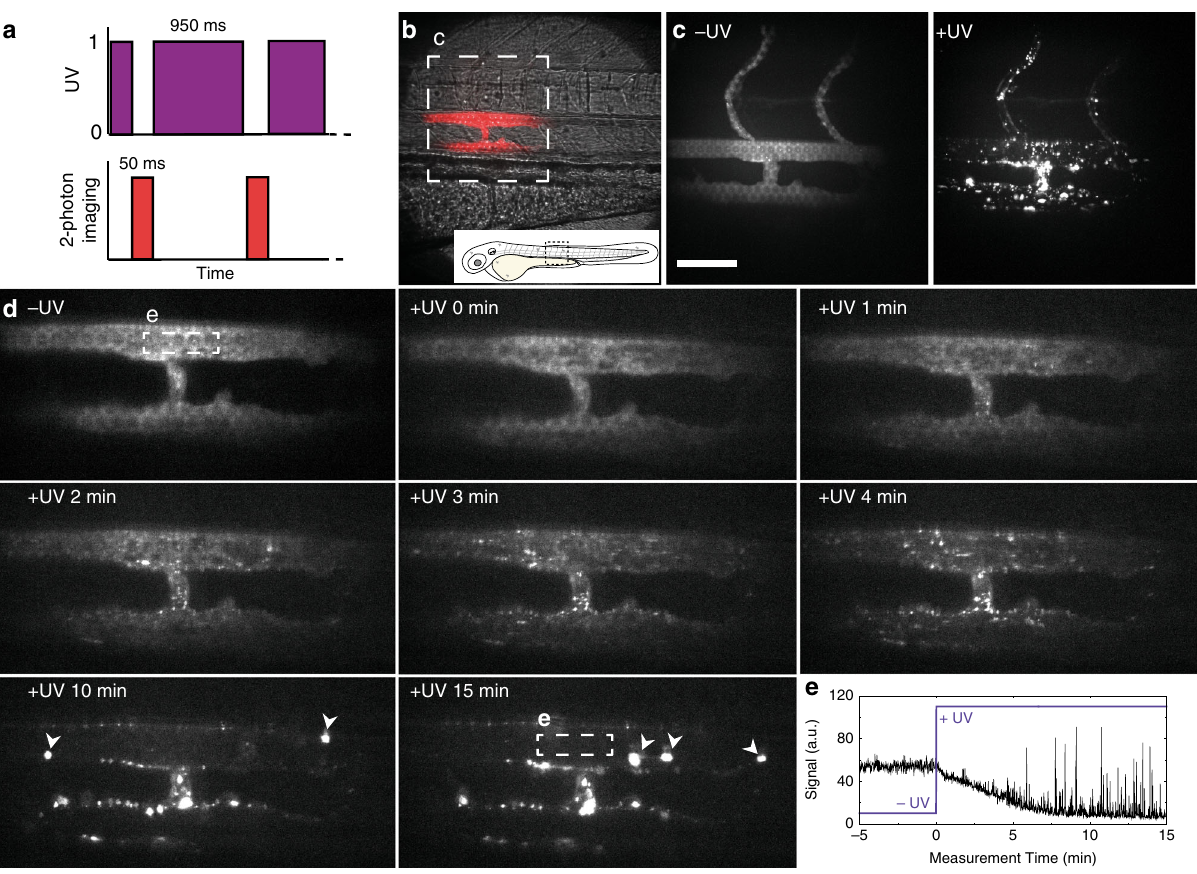
Fig. 5 Real time multi-photon imaging of liposome surface charge switching in situ and in vivo. a The zebra fi sh embryo was exposed to UV light between the acquisitions of the camera, resulting in a 95% duty cycle of UV illumination per frame. b Transmission image of the imaging location, emission image overlaid in red. c Maximum intensity projections of two-photon z-stacks (spanning the full width of the embryo) showing DOPC: 4 liposome distribution, before and after UV exposure. These images con fi rm the vessel connected to, and extending dorsally from the PCV, is an ISV. d Time-lapse images of DOPC: 4( → 3) liposome distribution before and during UV irradiation. In later timeframes, large clusters of liposomes (indicated with white arrowheads) were observed passing through the plane of view in circulation. e Mean fl uorescence intensity within the ROI (lumen of the DA, white square in ( c , 15 min). Liposome fl uorescence intensity immediately decreased upon UV irradiation. High intensity spikes of fl uorescence, due to large circulating liposome aggregates passing through the ROI, registered from 5 min after UV irradiation start. Liposomes contained 1 mol% fl uorescent lipid probe, DOPE- LR, for visualisation. Scale bars: 50 μ